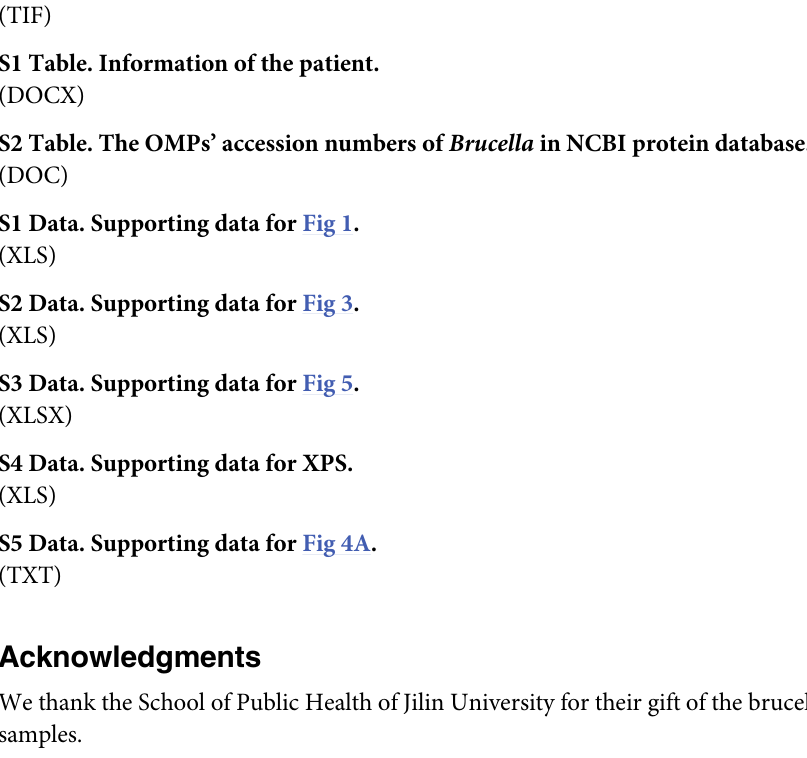
S1 Fig. Comprehensive sequence of amino acids of the fusion protein; the linkers are in red font. S2 Fig. Results of p-ELISA. (A) Positive of nano-p-ELISA. (B) Negative of nano-p-ELISA. ( C) Positive of tra-p-ELISA. (D) Negative of tra-p-ELISA. S1 Table. Information of the patient. S2 Table. The OMPs’ accession numbers of Brucella in NCBI protein database. S1 Data. Supporting data for Fig 1. S2 Data. Supporting data for Fig 3. S3 Data. Supporting data for Fig 5. S4 Data. Supporting data for XPS. S5 Data. Supporting data for Fig